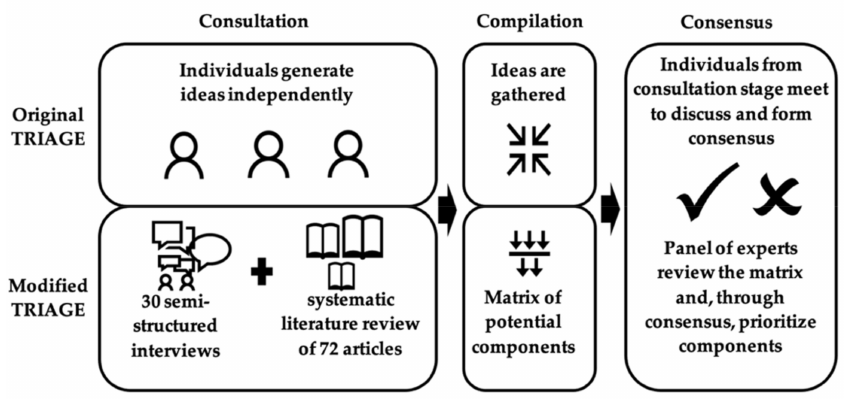
Figure 1. Modified